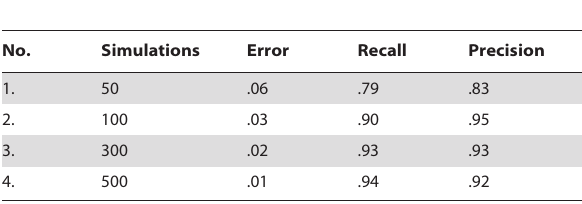
Table 4. Results for different number of simulations of SIGNET